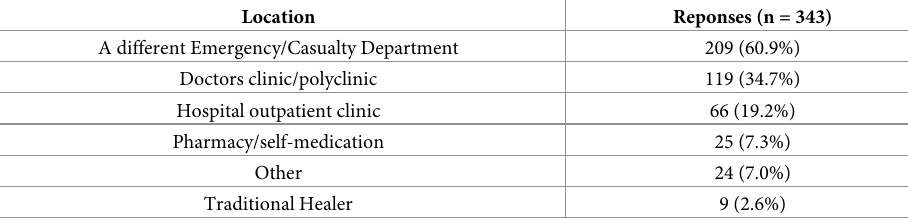
Table 4. Where did you seek care for your current problem prior to coming to the ED?.